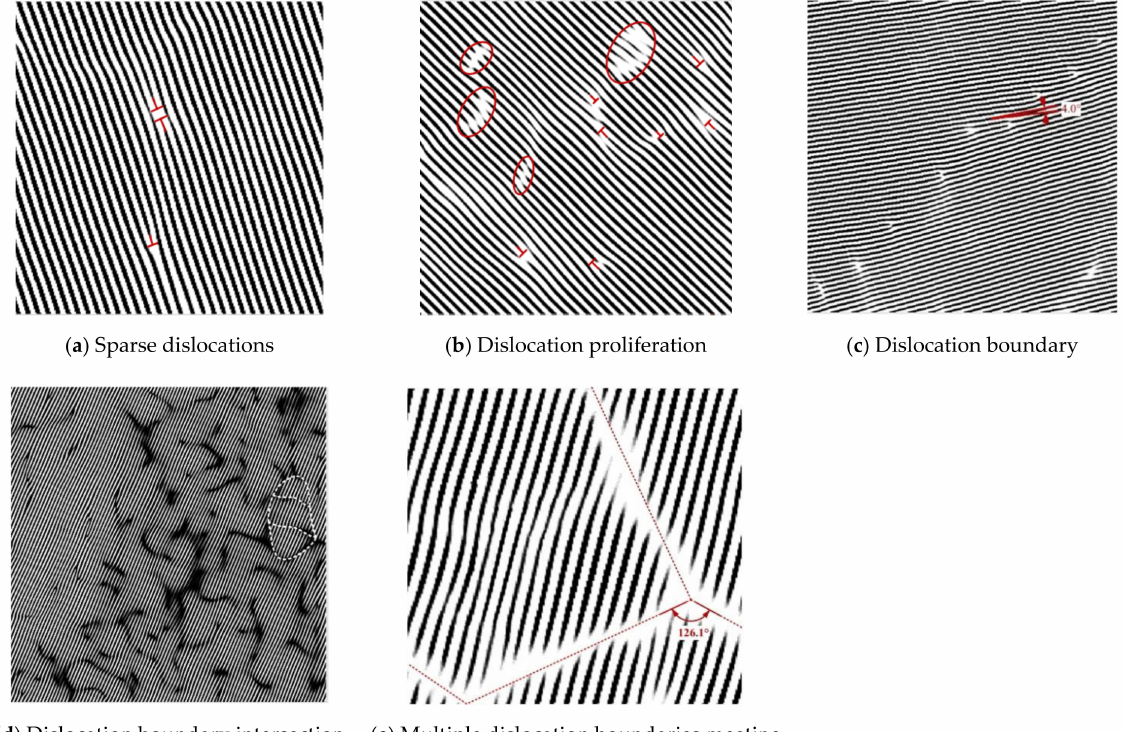
Figure 13. Characteristics of variation of the IFFT-filtered images of the NV E690 cladding layer surface caused by